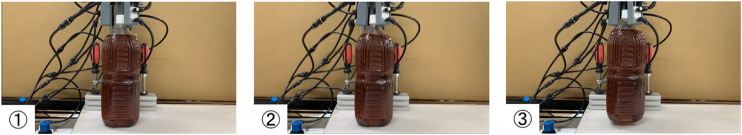
Gripping and releasing a 2 L PET bottle with three-fingered pneumatic gripper.